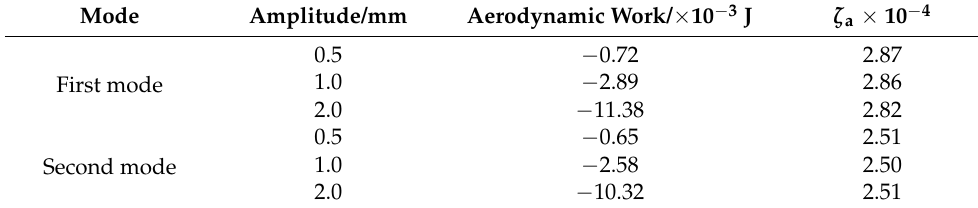
Table 3. Aerodynamic work and ζ a with different